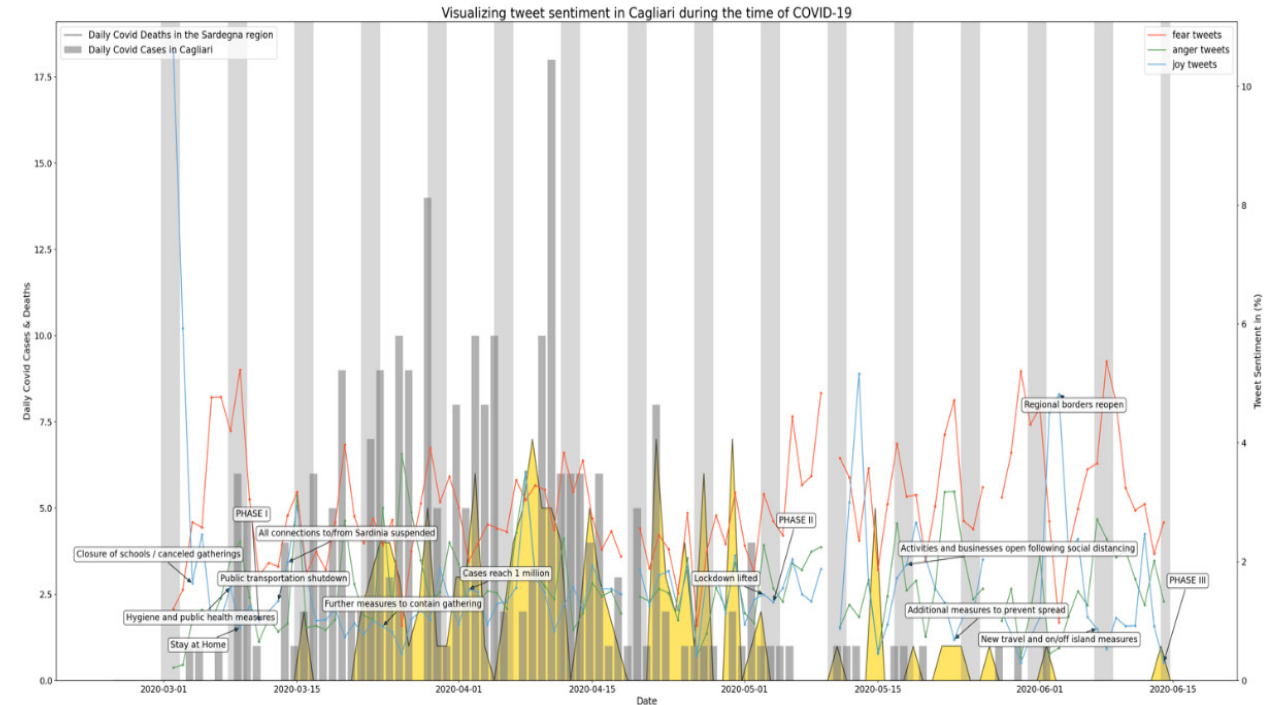
Figure A10. Visualizing Twitter sentiment in Cagliari during the time of COVID-19.